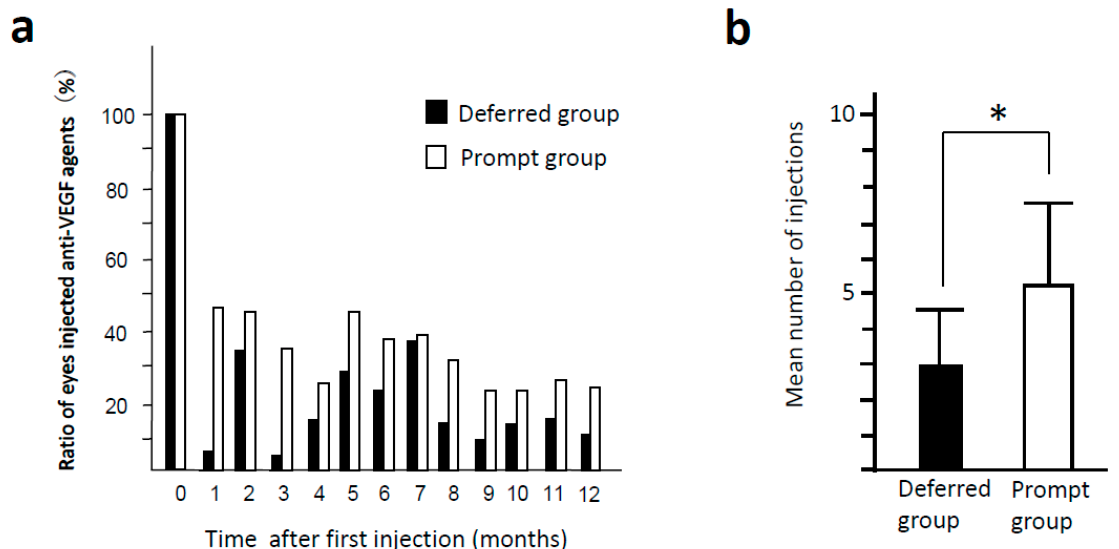
Figure 2. The number of injections of anti-VEGF agents in the prompt and deferred groups. ( a ) The change of the ratio of the eyes injected with anti-VEGF agents. ( b ) The mean number of injections in the prompt group was higher than that in the deferred group. * p < 0.05.